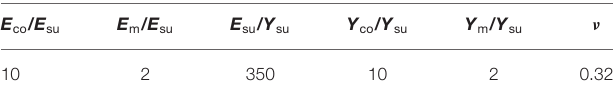
the bilayer case than the σ eq / Y at the same z / t location in the corresponding single-layer case.